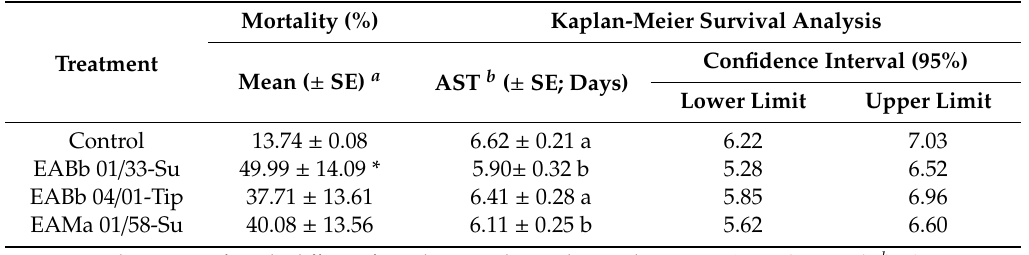
Table 3. Susceptibility of A. gossypii adults to entomopathogenic fungal isolates after exposure to leaves that were endophytically-colonized by those fungi.